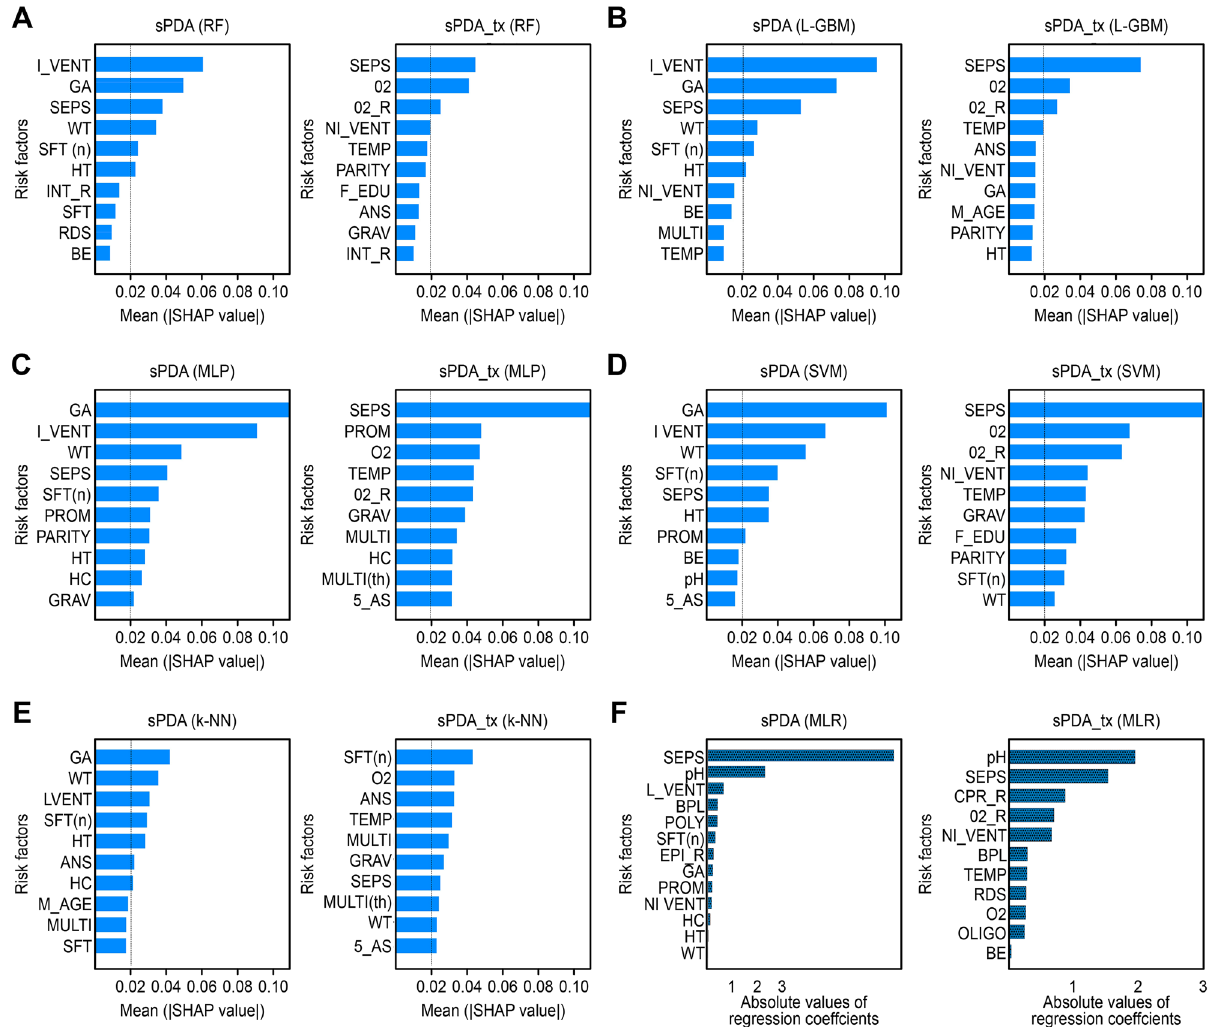
Figure 2. Top 10 factor contributions for sPDA and sPDA_tx prediction derived from each AA and MLR. ( a ) Risk factors for sPDA and sPDA_tx prediction according to the RF. ( b ) Risk factors for sPDA and sPDA_tx prediction according to the L-GBM. ( c ) Risk factors for sPDA and PDA_tx prediction according to the MLP. ( d ) Risk factors for sPDA and sPDA_tx prediction according to the SVM. ( e ) Risk factors for sPDA and sPDA_tx prediction according to k-NN. The risk factors are listed in order of the average absolute SHAP values yielded by each algorithm in the artificial intelligence analysis and were selected based on a p -value of 0.05 during the testing procedure; the selected factors are sorted in descending order according to the absolute values of the corresponding regression coefficients in the MLR. Abbreviations: sPDA, symptomatic patent ductus arteriosus; nPDA, asymptomatic PDA or spontaneously closed PDA; sPDA_tx, symptomatic patent ductus arteriosus with any treatment; sPDA_nontx, symptomatic patent ductus arteriosus without treatment; RF, random forest; L-GBM, light gradient boosting machine; MLP, multilayer perceptron; SVM, support vector machine; k-NN, k-nearest neighbors; MLR, multiple logistic regression. The abbreviations for all the factors are shown in Supplementary Table